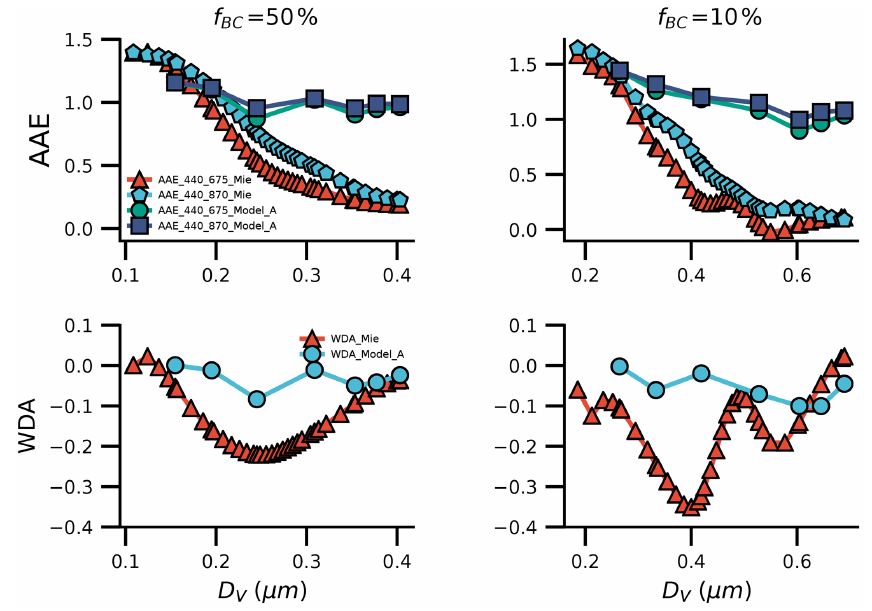
Figure 10. Comparison of AAE and WDA between core-shell sphere model and Model A. Here WDA represents the AAE difference between the 440–675nm wavelength pair and the 440–870nm wavelength